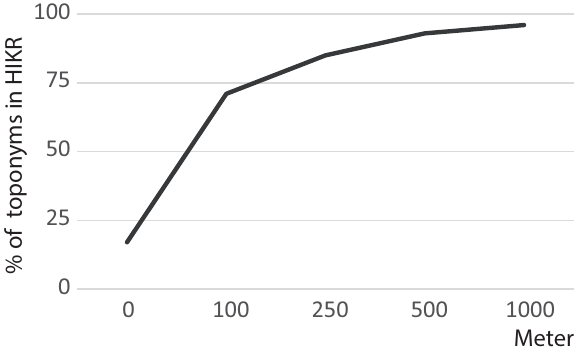
Figure 4: Cumulative curve of distance between Hikr toponyms and their entries in the authoritative SwissNames